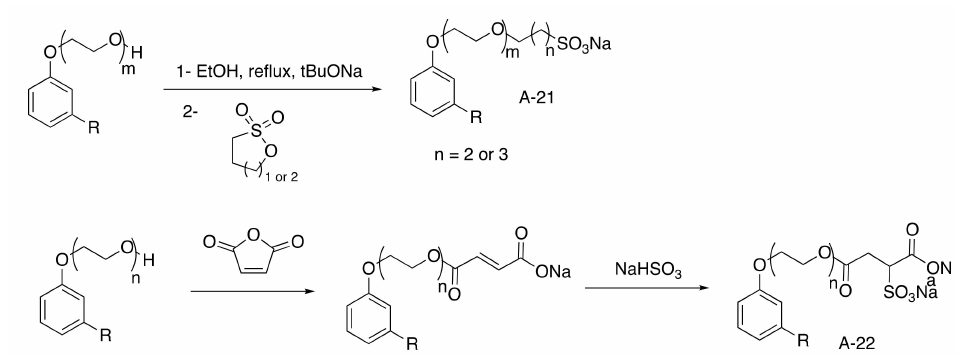
Scheme 8. Polymeric aliphatic sulfonated